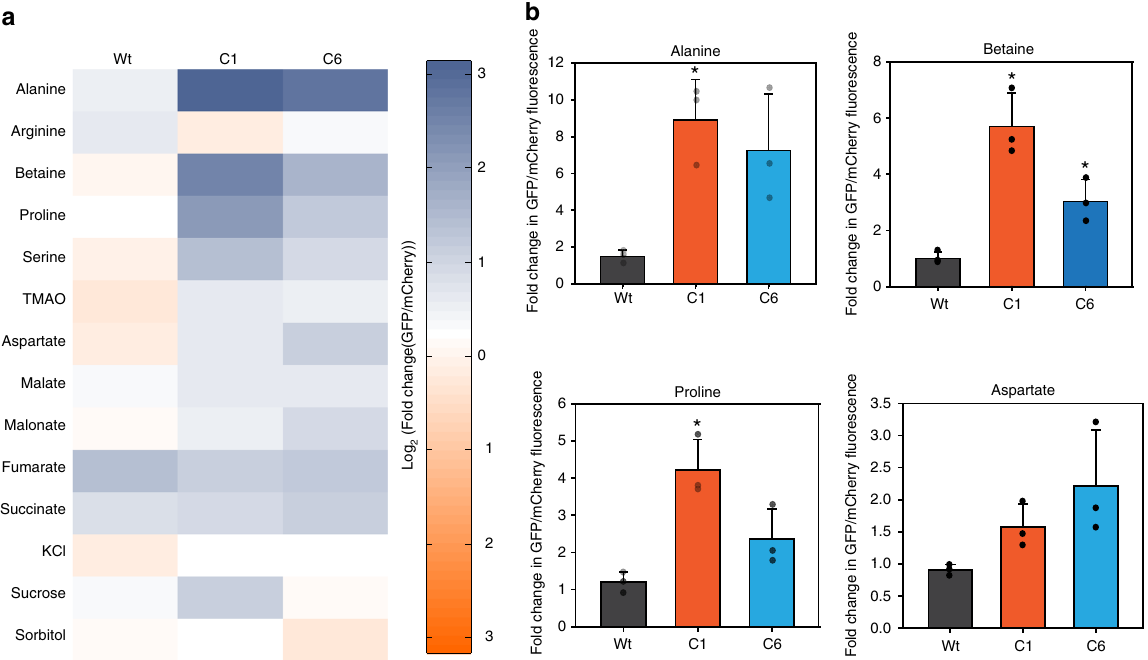
Fig. 7 Altering metabolism by exogenous supplementation modi fi es mutational buffering capacity. a Expression of Wt, C1, and C6 GFP mutants was induced in CSH4 cells either growing in LB or in LB containing different metabolites. Average of log2 of fold-change in median of GFP/mCherry fl uorescence as measured by single-cell fl uorescence from three replicates is shown as heatmap. b Mean of fold-change in median of GFP/mCherry fl uorescence in few metabolites (Alanine, Betaine, Proline, Aspartate) in CSH4 is shown as bar graph along with standard deviations from three biological replicates and P -value calculated with respect to Wt GFP by 2-sided Students ’ t -test, * p -value C1 Alanine: 0.02, Betaine: 0.01, Proline: 0.01; C6 Betaine: 0.03. (Source data are provided as source data fi le Fig.